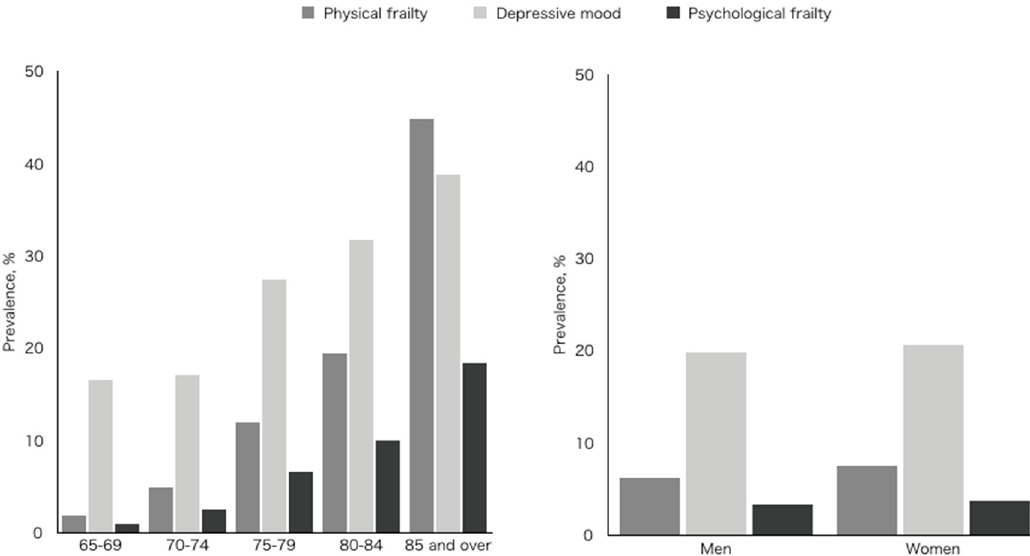
Figure 2. Prevalence of psychological frailty by age and sex.